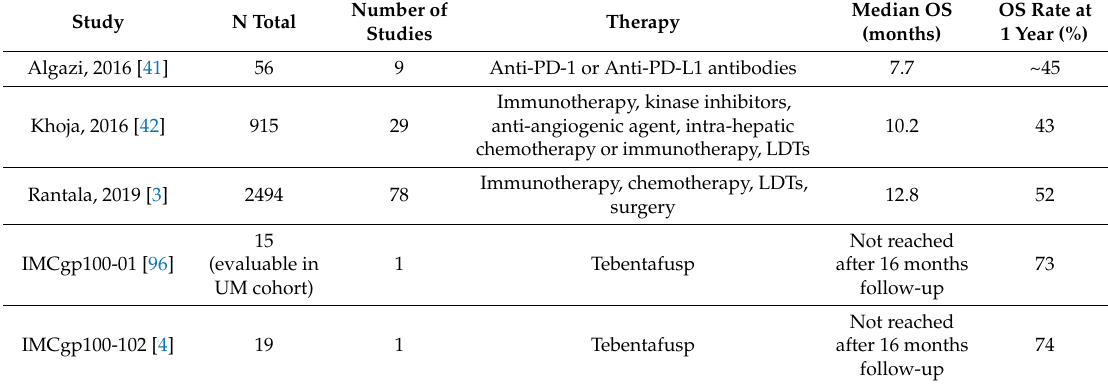
Table 2. Overall survival (OS) data with tebentafusp compared with results from three meta-analyses looking at a range of therapies for